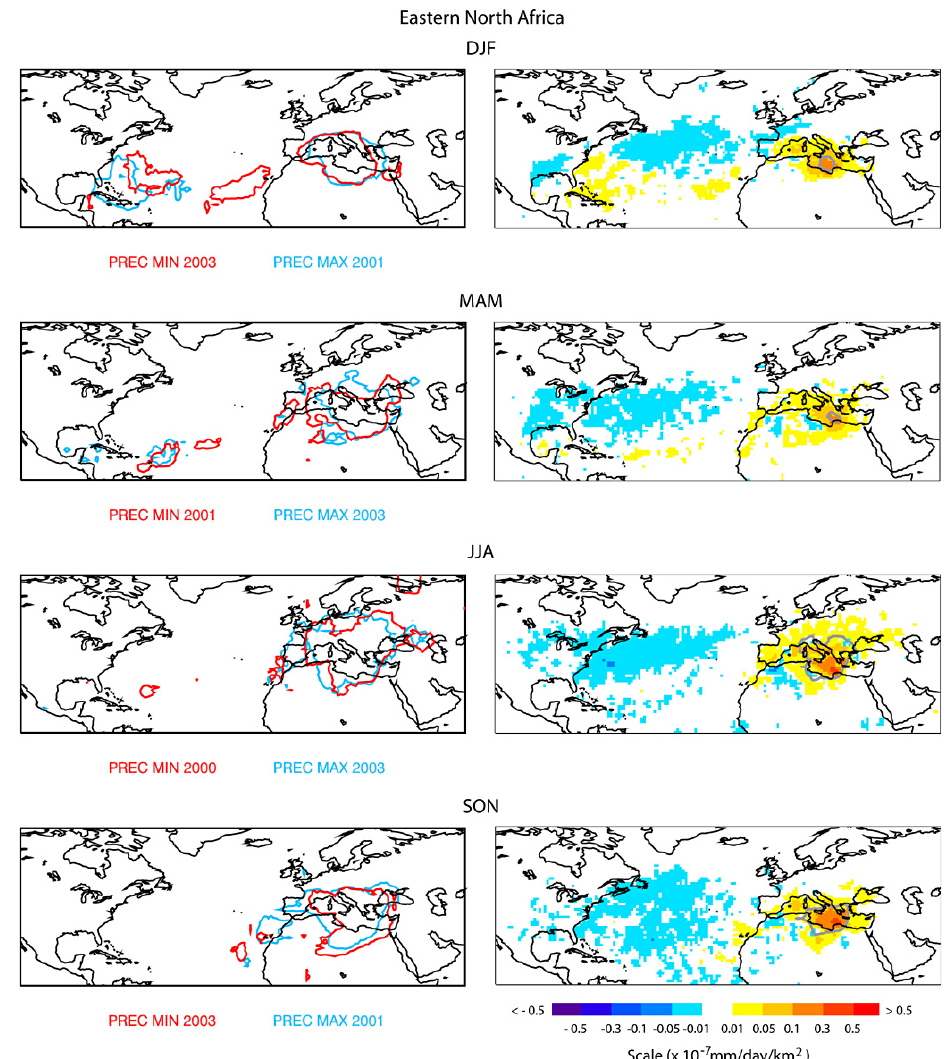
Fig. 7. As Fig. 2, but for the Eastern North Africa subregion (EA), considering its equivalent area as 518997km 2 .